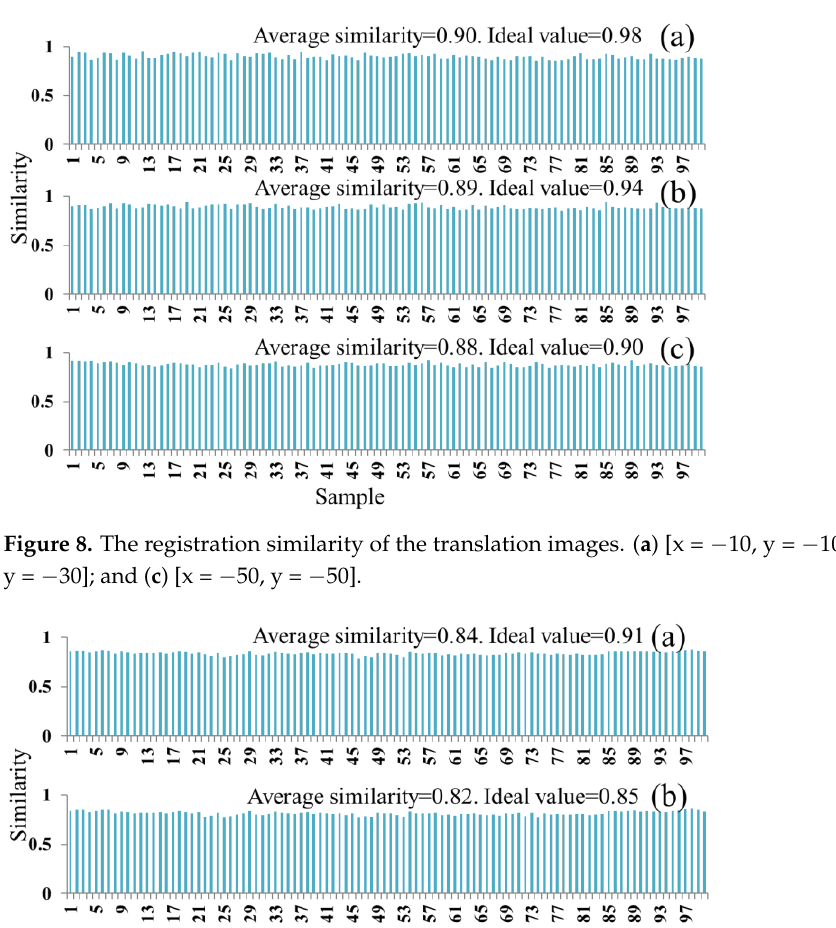
Figure 7. The registration similarity of the scaling images. ( a ) Scaling factor = 0.8; ( b ) scaling factor = 0.9; and ( c ) scaling factor = 1.1.